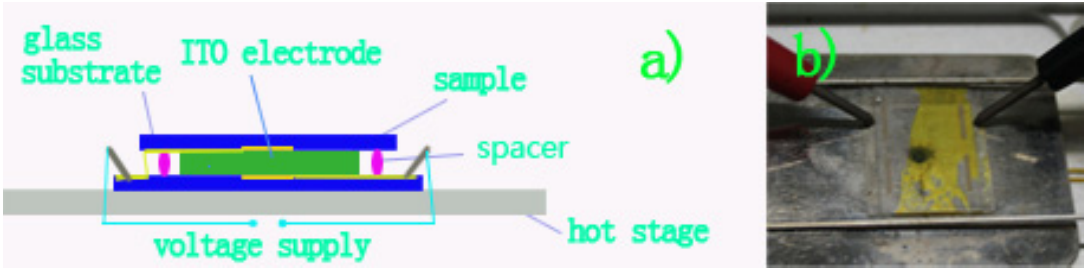
Figure 4. Photographs of the liquid crystal cell heated on hot stage with the application of vertical E-field.